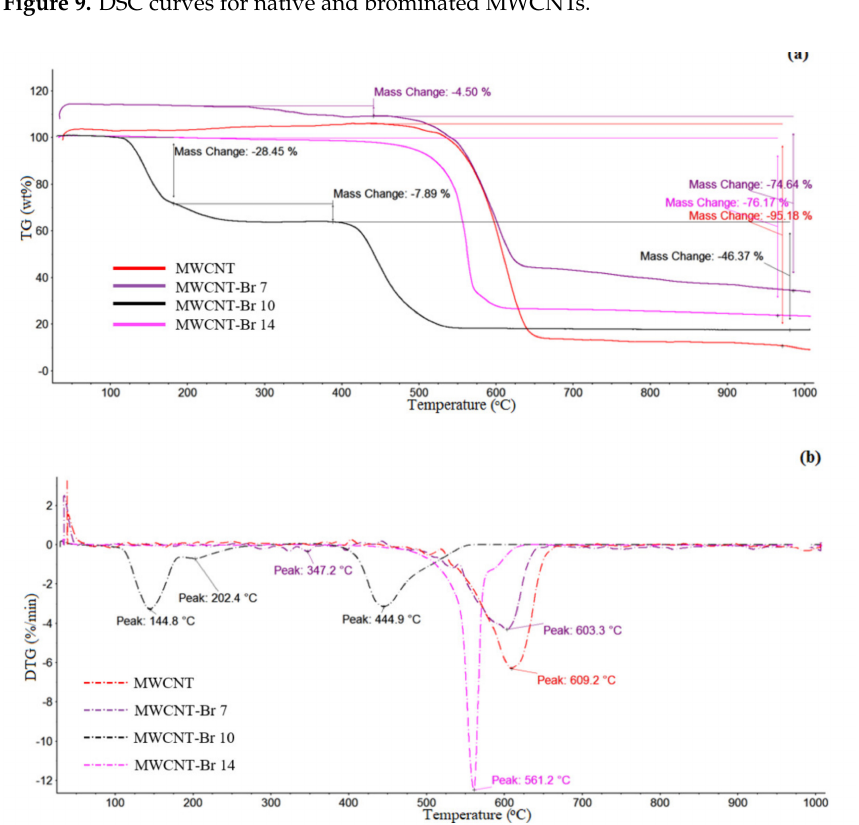
Figure 10. ( a ) Thermogravimetric (TG) and ( b ) differential TG (DTG) curves for native and bromi- nated MWCNTs. The insert shows the thermal behavior of the samples in the interval from 50 to 1000 ◦